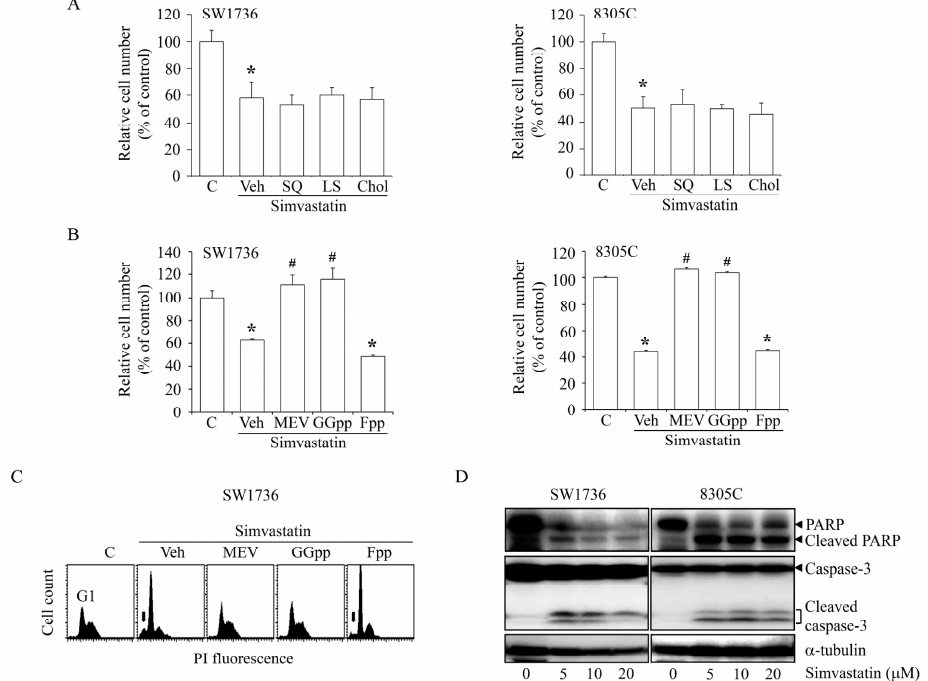
Figure 2. Effects of MEV-derived metabolites on the simvastatin-induced ATC cell proliferation inhibition. ( A ) Simvastatin (10 μ M)-inhibited proliferation of SW1736 and 8305C cells was not affected by the add-in SQ (10 μ M) or LS (10 μ M) or Chol (10 μ M). Cells were pre-incubated with SQ, LS or Chol for 30 min followed by simvastatin for additional 48 h. The simvastatin (10 μ M) induced cell proliferation inhibition ( B ) and accumulation of cells at the G1-phase ( C ) of SW1736 and 8305C cells were abolished by MEV (50 μ M) and GGpp (20 μ M), but not Fpp (20 μ M). Cells were pre-incubated with MEV, GGpp or Fpp for 30 min followed by simvastatin for additional 48 h. The relative cell number was estimated using MTT assays. Values represent the means ± SEM ( n = 3). The DNA content was measured by PI staining. Arrows indicated sub-G1 cell population. ( D ) Simvastatin triggered apoptosis in SW1736 and 8305C cells. Cells were incubated with 0–20 μ M simvastatin for 48 h, and then the protein expression levels of full-length and active form of caspase 3 and PARP were examined by immunoblotting analysis. * p < 0.05, different from corresponding control. # p < 0.05, different